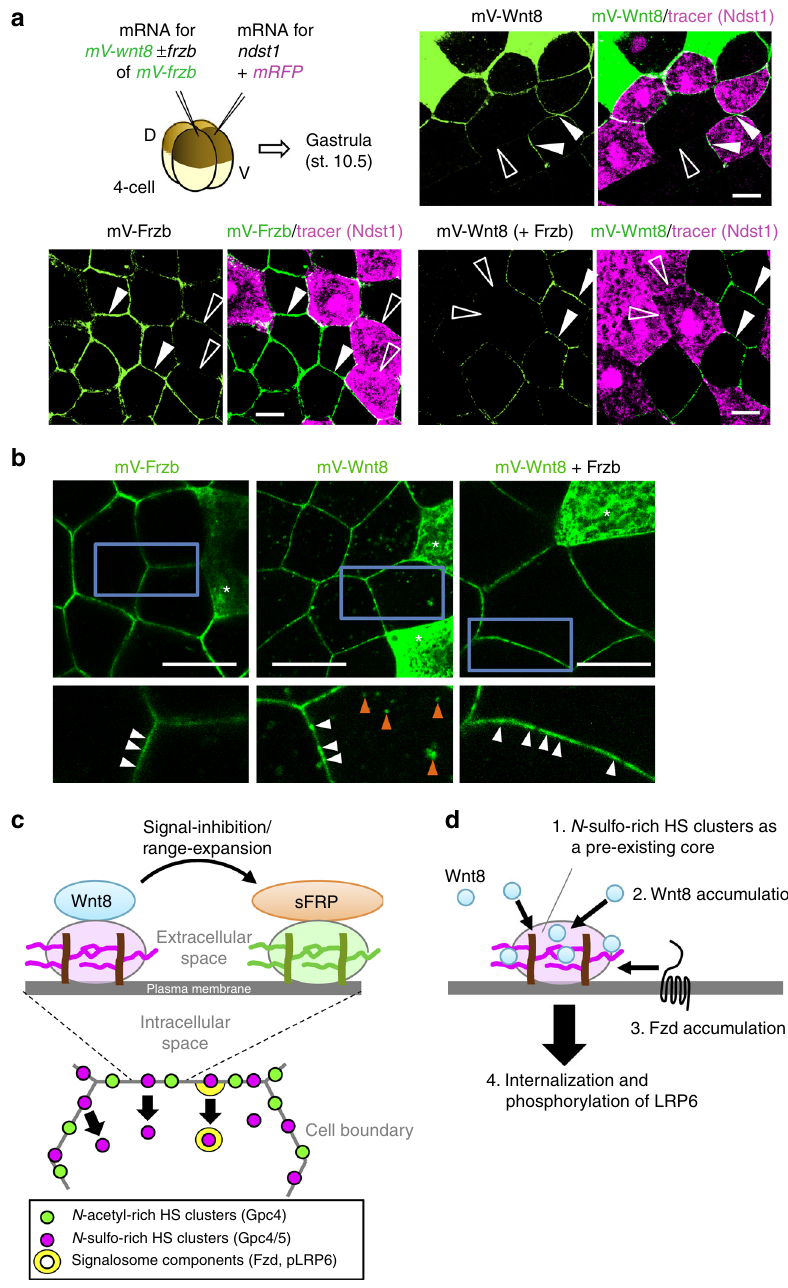
Fig. 10 Frzb shifts Wnt8 from N- sulfo-rich to N- acetyl-rich HS clusters. a Frzb inhibits the accumulation of Wnt8 on ndst1 overexpressing cells. Experimental procedures were as illustrated. Although mV-Wnt8 was accumulated on ndst1 -overexpressing cells (upper right), mV-Frzb was not accumulated on ndst1 -overexpressing cells (lower left). When coexpressed with Frzb, mV-Wnt8 was not accumulated on ndst1 overexpressing cells similar to Frzb (lower right). b Frzb inhibits internalization of Wnt8. Left panels, the characteristic puncta of mV-Frzb (asterisks, source cells of mV-Frzb). Middle panels, mV-Wnt8 in the intercellular space (white arrowheads) and inside the cells (orange arrowheads) (asterisks, source cells of mV-Wnt8). Right panels, in the presence of Frzb, punctate staining of mV-Wnt8 (asterisks, source cells of mV-Wnt8) became smoother in the intercellular space (white arrowheads) and was barely detected inside the cell. Lower panels, magni fi ed images of the boxed regions in the upper panels. mV-wnt8 and frzb mRNAs were separately injected into different blastomeres. c A model of the N- sulfo-rich and N- acetyl-rich HS cluster system for the regulation of the extracellular distribution and signal reception of the Wnt morphogen. d A model for the initiation of signalosome formation. N- sulfo-rich HS clusters (magenta) work as a pre-existing core to accumulate Wnt8 (green) prior to the recruitment of the Fzd receptor and following phosphorylation of LRP6. Images are a representative of at least two independent experiments. Amounts of mRNAs (ng/embryo): mV-wnt8 , 1.0 ( a ) or 2.0 ( b ); mV-frzb , 0.39 ( a ) or 2.0 ( b ); frzb , 0.48 ( a ) or 2.5 ( b ); ndst1 , 0.5. Scale bars, 20 μ m. a.u., arbitrary